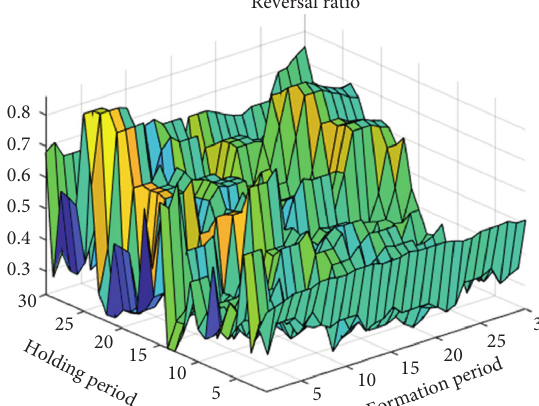
Figure 1: Daily reversal ratios in various periods. In the figure, the daily reversal ratios are plotted for various testing formation and holding periods. The maximum formation and holding periods are 30 days each, allowing 900 cases to come into being. We calculate the percentage of stocks that reverse their past price trends in the future. The reversal ratio is ( # ( REVS ) /# ( MOMS )) , where # ( REVS ) denotes the number of stocks reversing their prices and # ( MOMS ) is the total number of stocks within a momentum